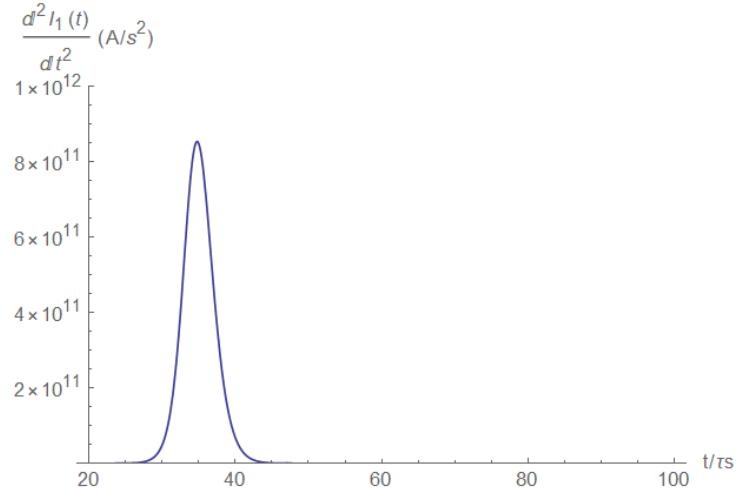
Figure A20. The source current second